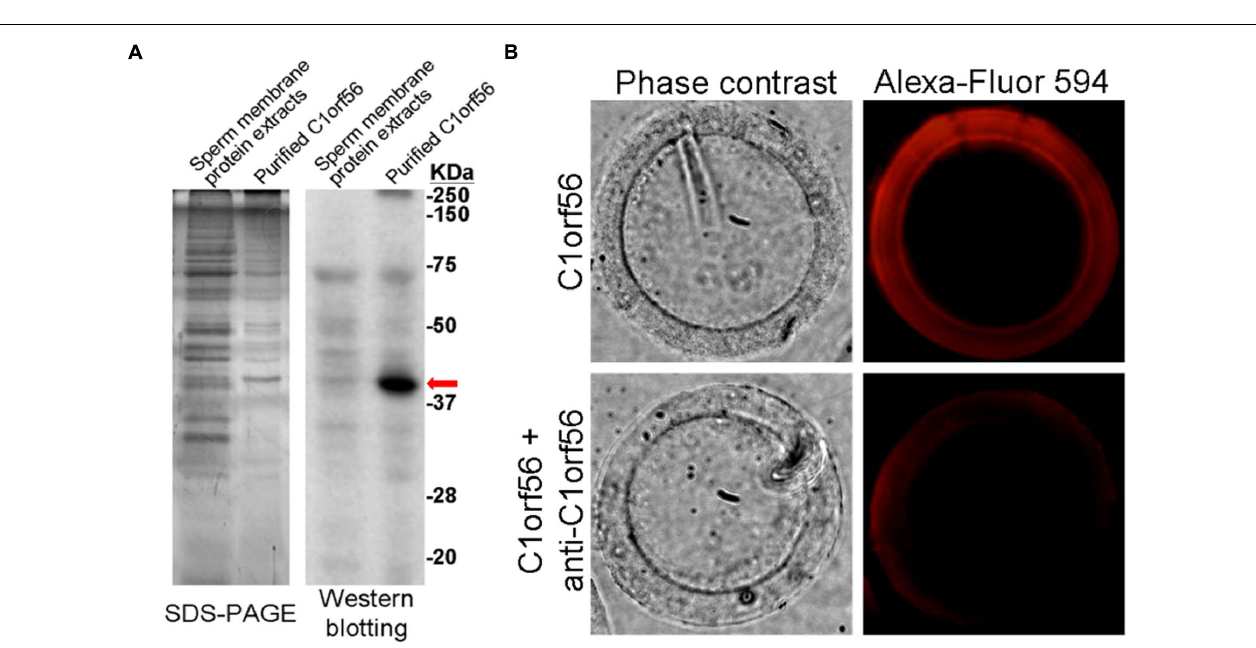
FIGURE 5 | Anti-C1orf56 antibody inhibits spermatozoa-SLeX binding. Capacitated sperm were incubated with 0.5 µ M Alexa Fluor-594 labeled SLeX-BSA in the presence or absence of 1 µ g/ml anti-C1orf56 antibody for 120 min followed by the flow cytometry analysis. The results shown are representative of three replicate experiments. * P < 0.05 when compared with the control without anti-C1orf56 antibody.